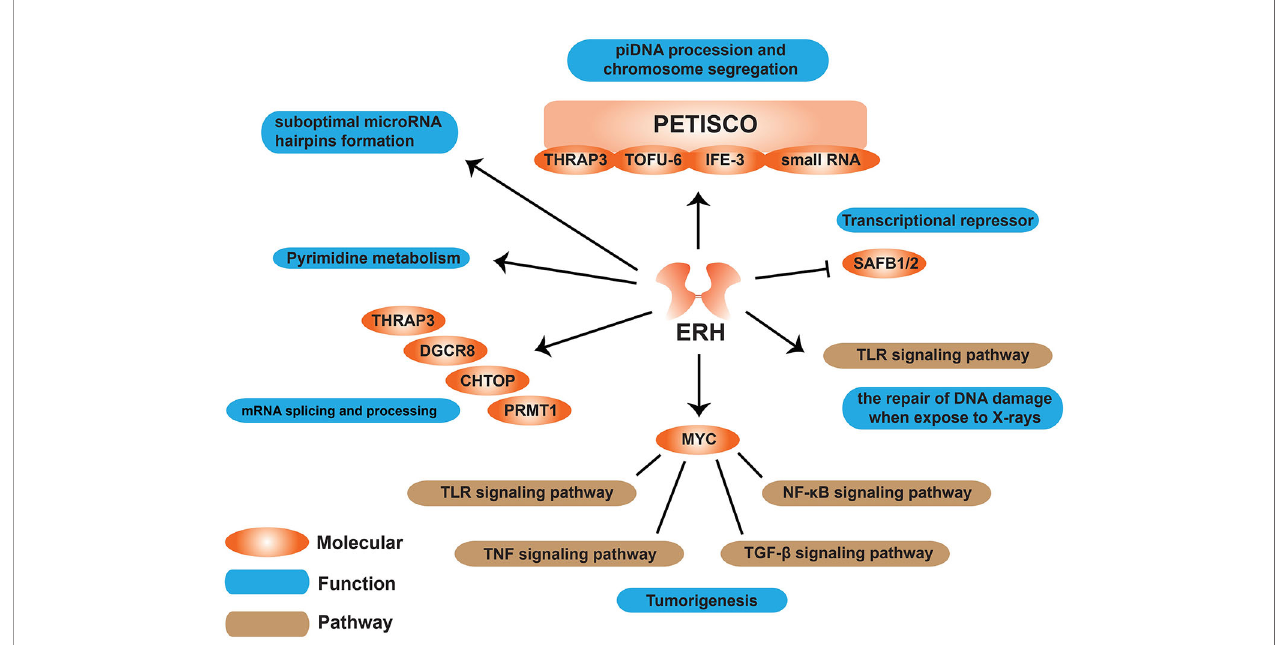
FIGURE 3 | Schematic diagram of functions ERH protein involved in cells. ERH protein can affect many molecules like MYC, SAFB1/2, and some pathways to have an effect on some functions on “ tumorigenesis ” , “ mRNA splicing and processing ” , “ pyrimidine metabolism ”